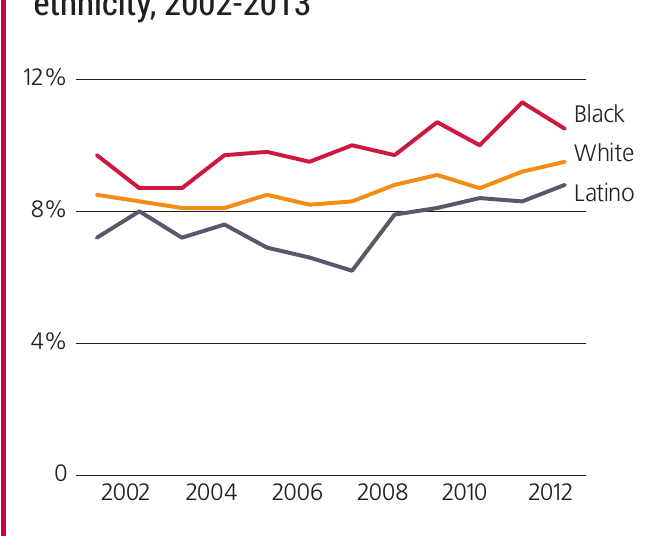
Figure 8. Illicit drug use in past month among persons aged 12 or older, by race/ ethnicity,